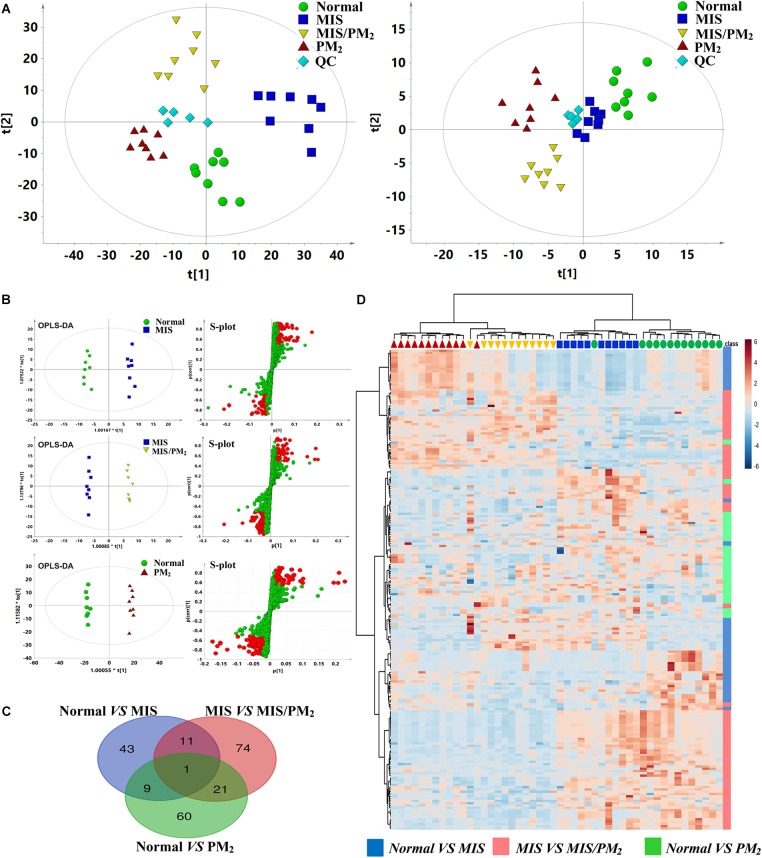
Metabolomic analysis of PM-IDILI in rats. (A) PCA score plot of different groups in positive and negative ESI modes. (B) OPLS-DA score plot and S-plots displayed for two groups (Normal vs. MIS, Normal vs. PM, and MIS vs. MIS/PM). (C) The shared and unique numbers of metabolites were also visualized in Venn diagram from Normal vs. MIS, Normal vs. PM, and MIS vs. MIS/PM. (D) Clustered heat map of the 219 significantly changed ions among the normal, MIS, PM, and MIS/PM groups. The colors from blue to red indicate the relative contents of metabolites.